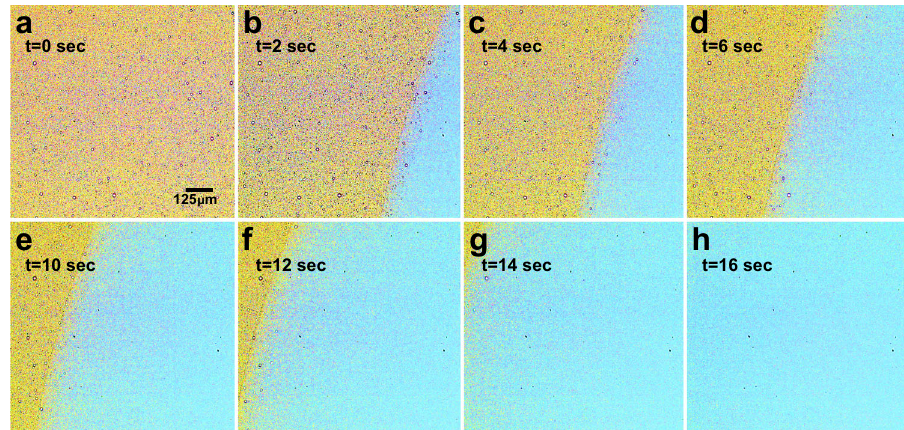
Fig. 10 Compilation of video microscopy image frames of NaOH dissolving the pMPC-pAA complexes. A very small volume of NaOH solution was dropped beside a drop of the polymer mixture (in yellow), and the resulting solvent front (cyan) was recorded using a polarized objective with 10X magni fi cation. Frames at 2 s intervals were captured using the Phantom PCC imaging software, and presented in order from panel ( a – h ). The scale bar in panel ( a ) corresponds to a length of 125 μ m, and is consistent throughout the frames. Images have been enhanced and recoloured for the sake of